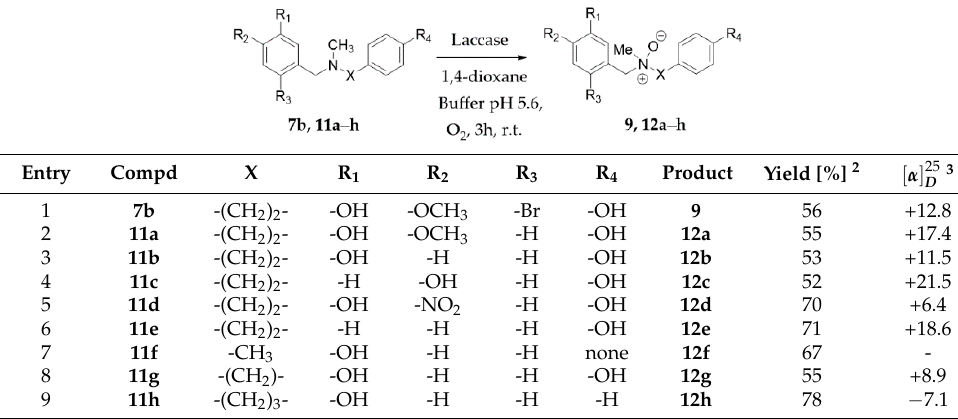
Table 2. Synthesis of belladine N -oxide derivatives 9 and 12a – h 1.